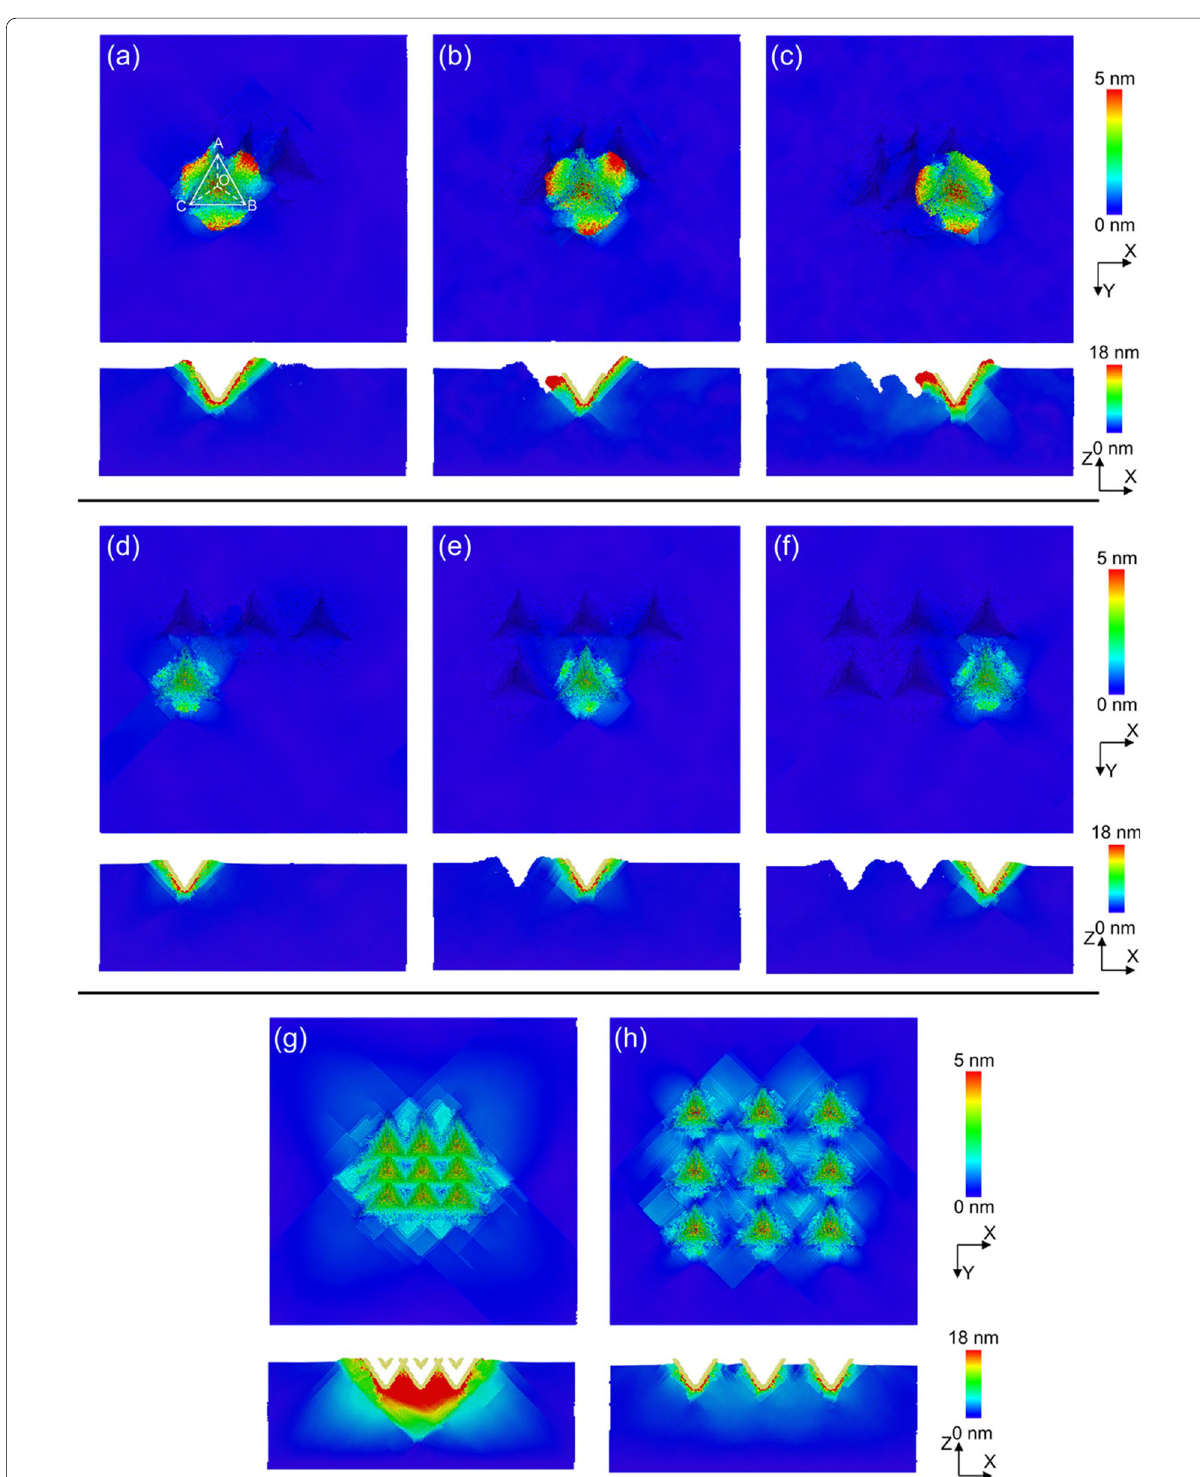
Fig. 3 Atomic displacement diagram of nanoindentation a the fourth indentation of Single-indenter with feed Single-indenter with feed 5 nm, c the sixth indentation of Single-indenter with feed = feed 10 nm, e the fifth indentation of Single-indenter with feed = multi-indenter indentation with feed 5 nm, f the multi-indenter indentation with feed =